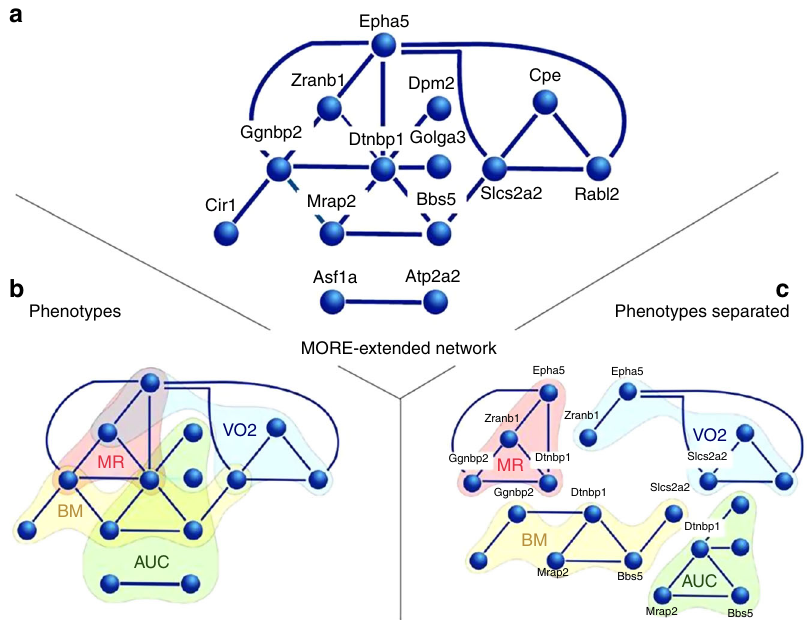
Fig. 5 MORE set-derived network of the 20 genes having two or more phenotypic associations. Genes were selected from the strong metabolic phenotype list with two or more phenotypic associations to metabolic traits. Genes were chosen as targets to examine shared links to regulatory networks. a Connection of 12 genes and 2 other genes by MORE sets found in their promoters. b The MORE-derived network from a with gene – phenotype associations superimposed as colored areas. This superposition joins the 14 genes to one network. c Four phenotypes are shown separated from each other along with the links between these strong metabolic phenotype genes. This will facilitate recognition of the individual